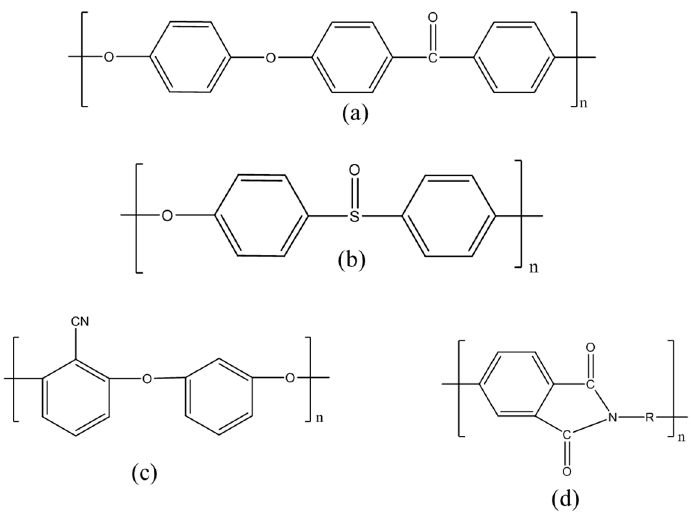
Figure 3. Chemical structures of ( a ) PEEK, ( b ) PES, ( c ) PEN and ( d ) cyclic PI.